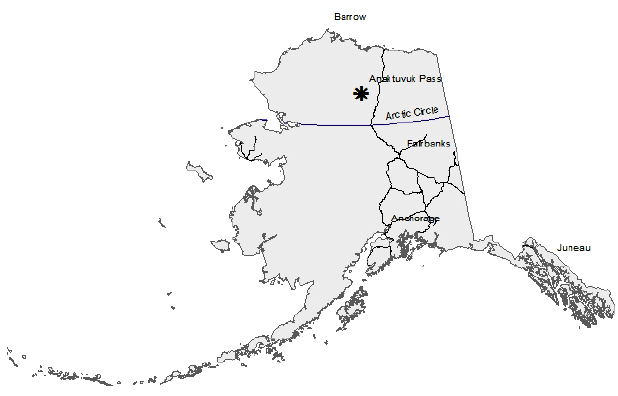
Fig. 1. Map of Alaska, USA, showing Anaktuvuk Pass.